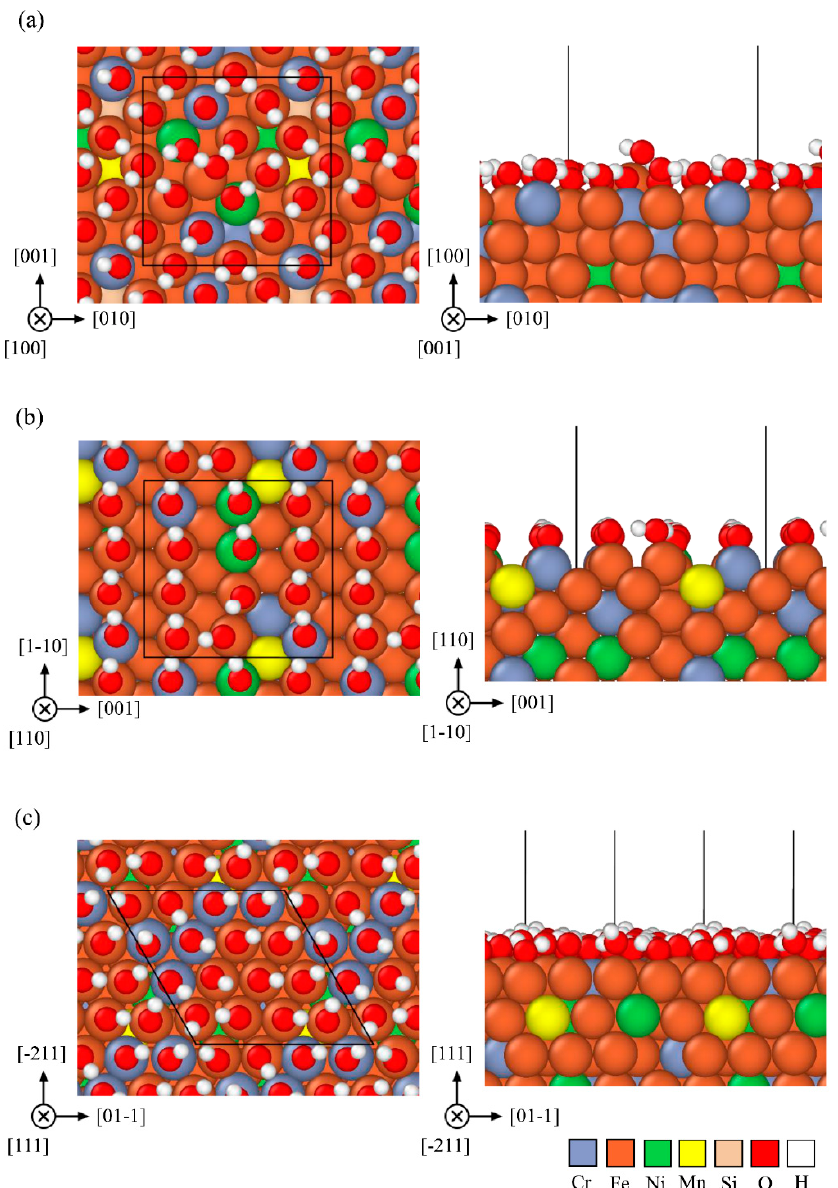
Figure 9. Top and side views of the atomic geometry of monolayer OH on facets ( a ) (100) ( b ) (110), and ( c ) (111) of FCC structure for 304SS specimens derived from the first-principles calculations.